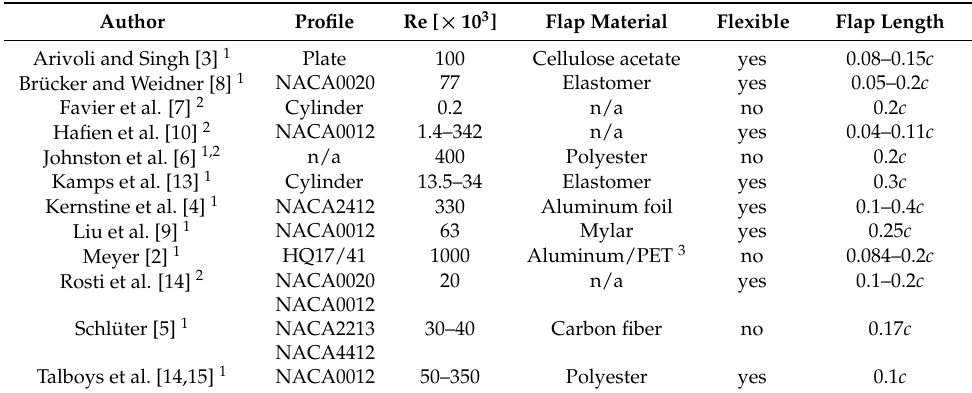
Table 1. Summary of the literature review with investigated profiles, Reynolds number Re of the flow, flap material, flexibility of the flap, and length with respect to the chord length of the profile c ; 1 Experimental study; 2 Numerical study; 3 Polyethylene